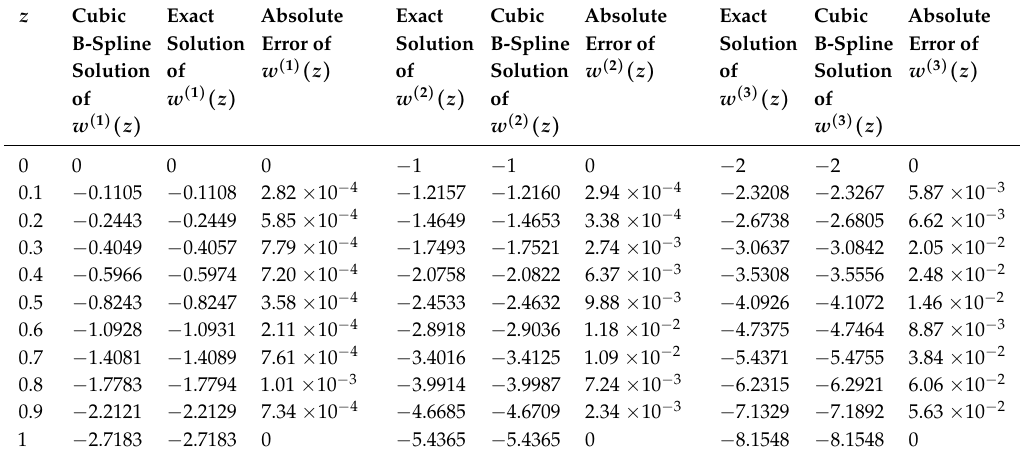
where boundary conditions are defined in Problem 1. 10